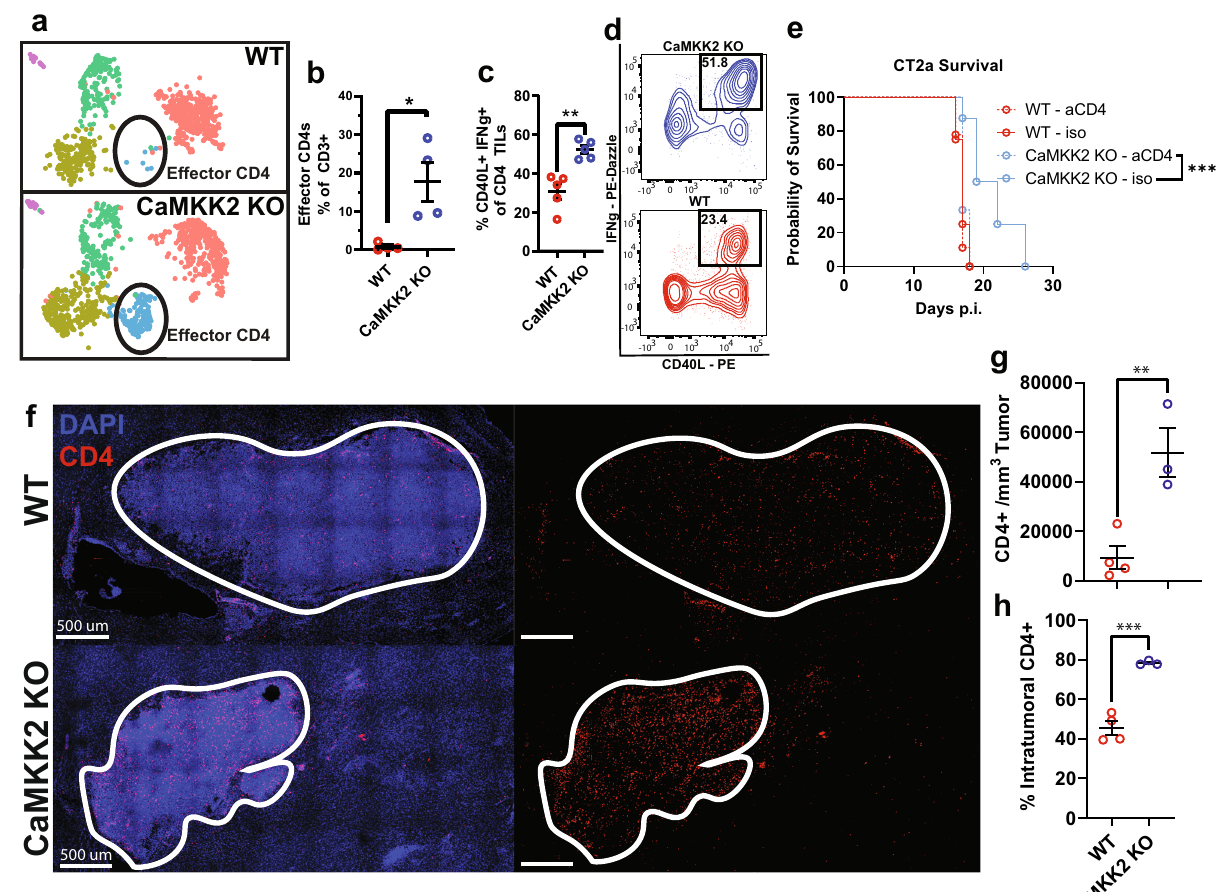
Fig.5|CaMKK2de fi ciencypromotestumorin fi ltrationofeffectorCD4 + Tcells. a UMAP plots of reclustered TILs strati fi ed by genotype b Abundance of Effector CD4 + TILsasa percentage ofreclustered TILs. n =4 per genotype, two-tailed t -test. * p =0.0156. c , d Tumor-bearing hemispheres were harvested on D14 post CT2a implantation and stained with a multi-color fl ow cytometry panel to assess abun- danceofCD4IFN γ + CD40L + TILs. n =5 per genotype, two-tailed t -test. ** p =0.0015. e 50k CT2a was implanted intracranially and mice were monitored for survival. Either 200ug of isotype or aCD4 was administered on D-3,D-2,D-1, p.i. and every 3 days after through D14 for a total of 8 treatments. n =8 per group, Log-rank test.